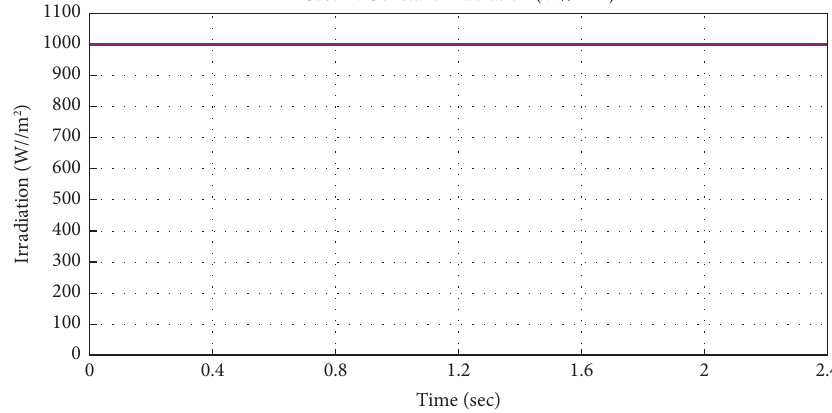
1 , inductor L 2 , and combined L 1 and L 2